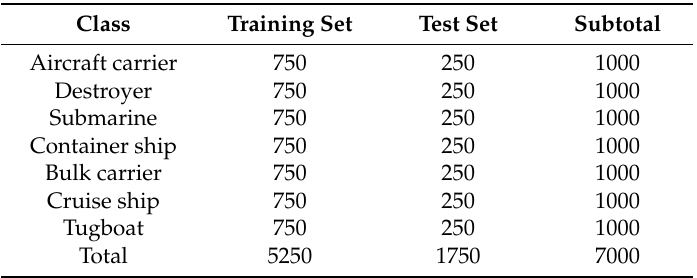
Table 2. The number of images in the ship